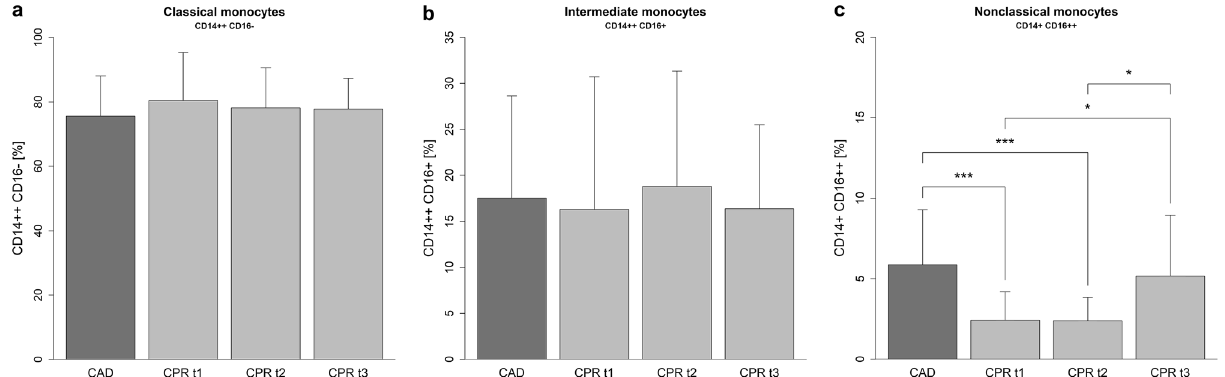
Figure 1. Monocyte subset composition in resuscitated patients and the control group. The relative fraction of monocyte subsets from the CPR group in the first 12 h (CPR t1: n = 22), after 24 h (CPR t2: n = 21) and 48 h (CPR t3: n = 16) following ROSC, and the control group (CAD: n = 19) is shown. Statistical hypothesis testing was performed using the Kruskal–Wallis test and post-hoc analysis with all-pairwise comparisons using the Dunn–Bonferroni approach (*: p ≤ 0.05; ***: p ≤